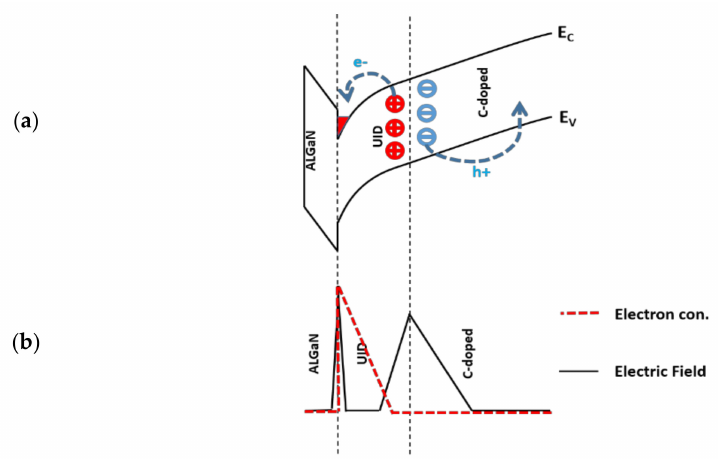
Figure 8. ( a ) Schematic band diagram under V stress , showing the ionization of donor and acceptor traps at the unintentionally doped (UID)/C-doped GaN junction. ( b ) Electric field and electron concentration under V stress at the UID/C-doped GaN